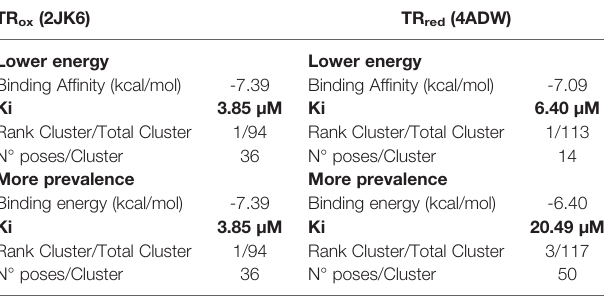
Results of 500 docking runs performed with the AutoDock-based Lamarckian Genetic Algorithm (LGA). Grid map was built around the active site residues of TR on oxidized and reduced